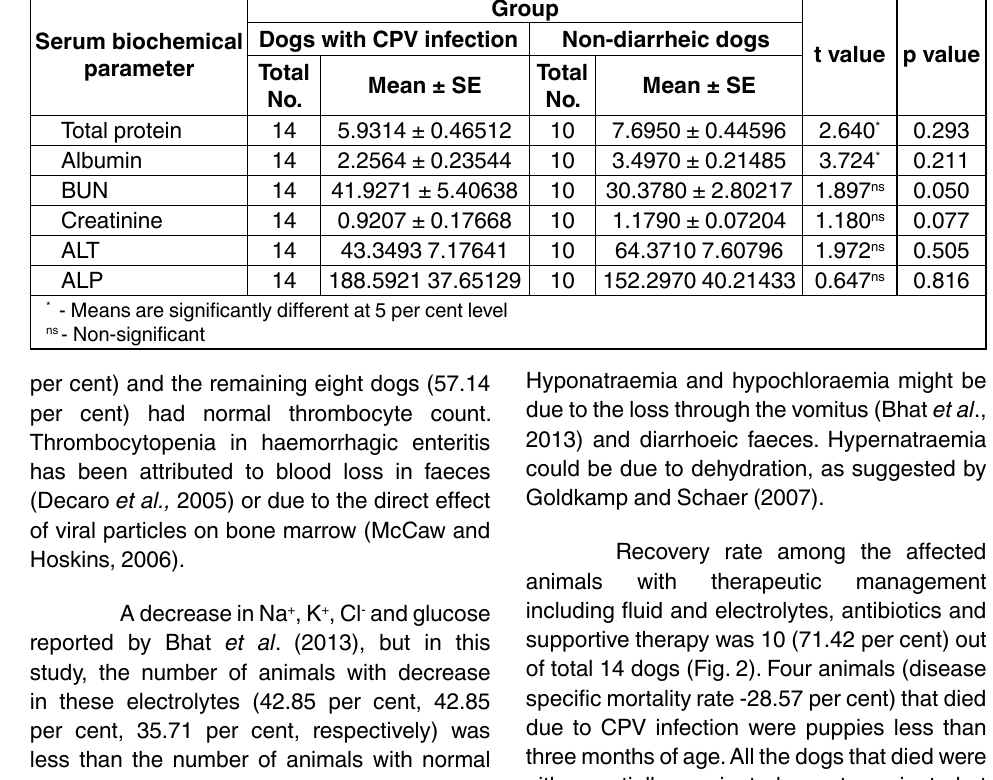
table 9. Comparison between serum biochemical values of CPV infected and control dogs serum